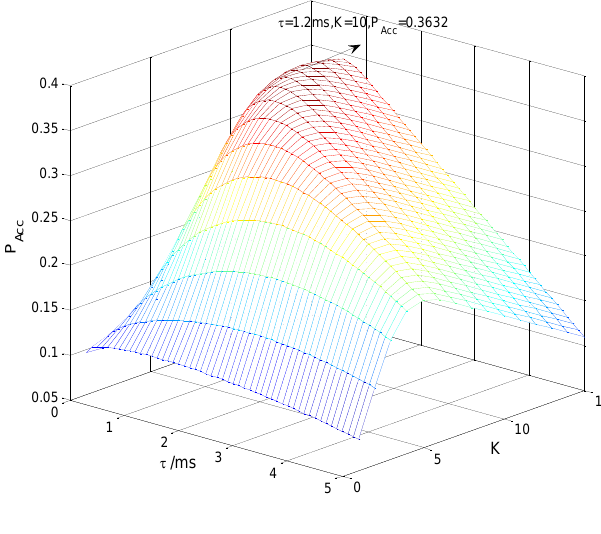
Figure 13. Spectrum access probability.